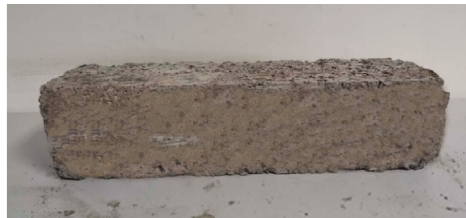
Figure 10: Cement-stabilized crushed stone molding test piece.